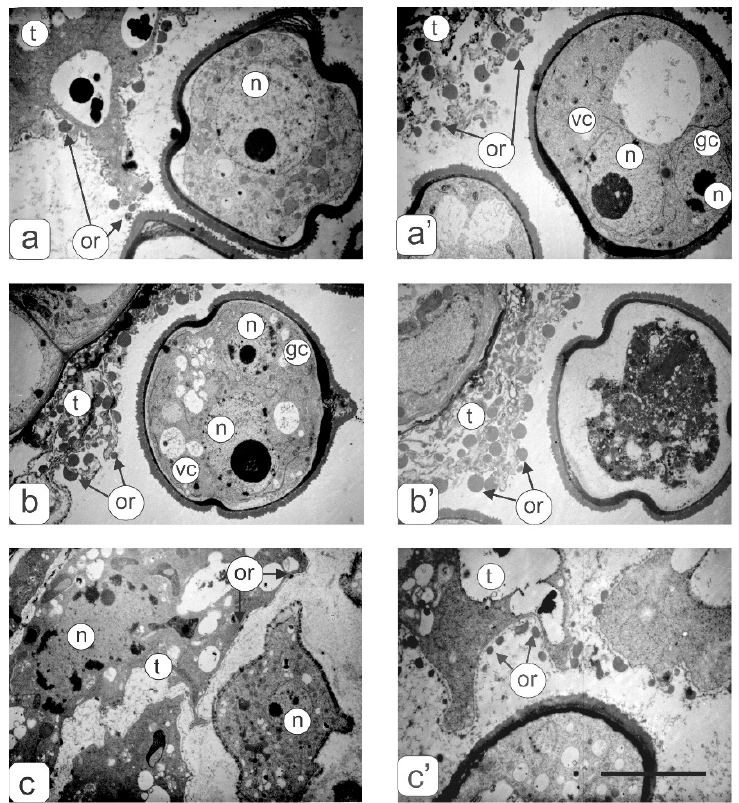
Figure 6. Ultrastructural fragments of anthers transverse sections in the tapetum zone: ( a , a’ ) control tomato plants at the microspore (a) and asymmetric mitosis (a’) stages; ( b , b’ ) transgenic tomato plants with a normal phenotype at the mitosis stage; ( c , c’ )—transgenic tomatoes with three (c) and two (c’) types of anther abnormalities. Symbols: t—tapetum; g с —generative cell; vc—vegetative cell; n—nucleus; or—orbicules. Bar—6 μ m.